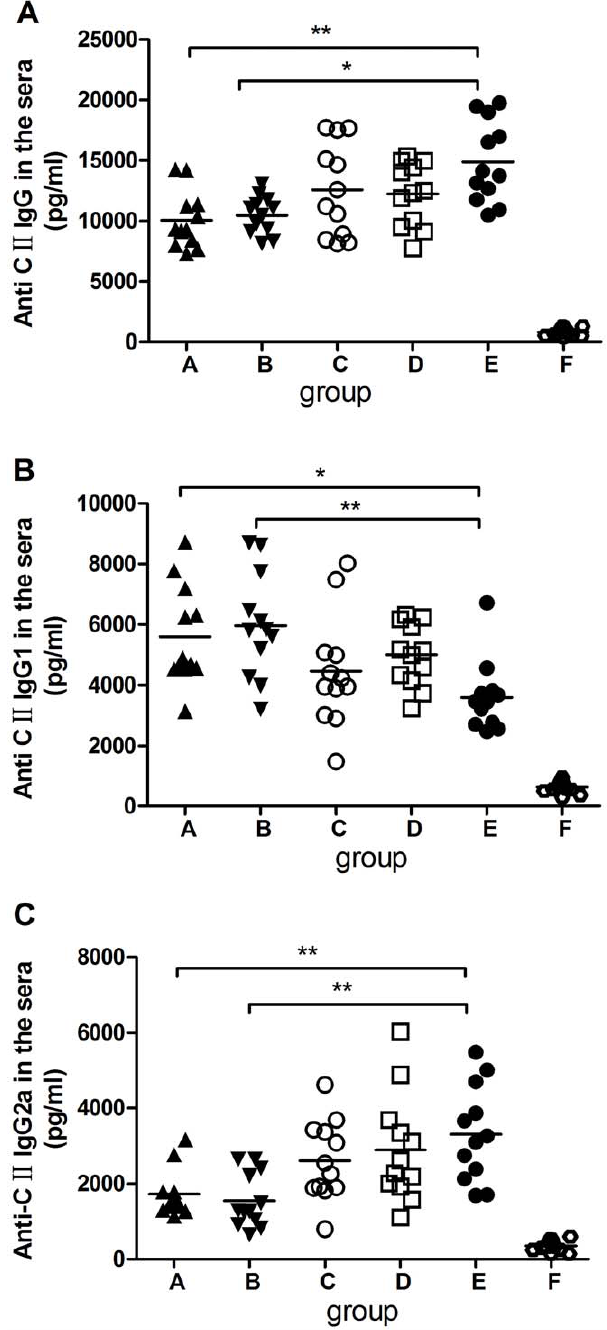
Figure 2. Effects of S. japonicum infection on anti-type-II collagen (anti-CII) antibody production. S. japonicum infection alters the levels of auto-antibodies in CIA mice. Sera were taken from DBA/1 mice 12 weeks after CII immunization. The concentration of anti- CII IgG and its subtype antibodies were determined by ELISA. The levels of anti-CII IgG and its subtypes were elevated in CIA mice. Compared with uninfected CIA mice, prior schistosome infection significantly reduced the levels of IgG and IgG2a in the sera, while the level of IgG1 was elevated in the infected mice. However, there was no statistically significant difference in the post schistosome infected CIA mice. No difference was observed between unisexual and bisexual infected mice. Means 6 SD data for each mouse are shown. Compared with CIA control group, *: P , 0.05; **: P , 0.01. Data are representative of